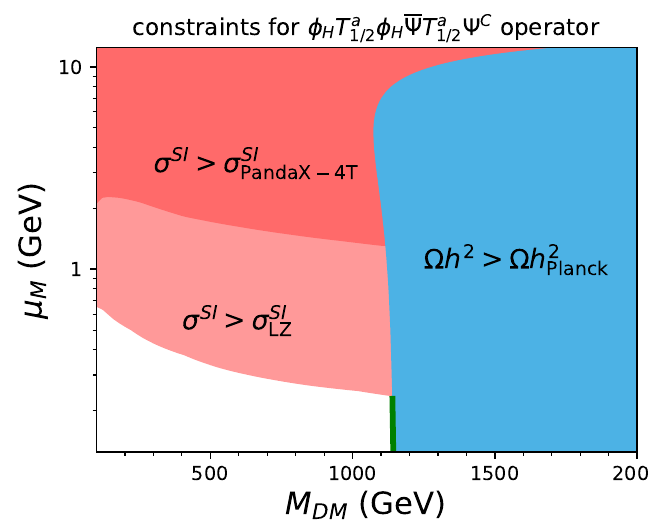
˜ model F 1 / 2 1 / 2